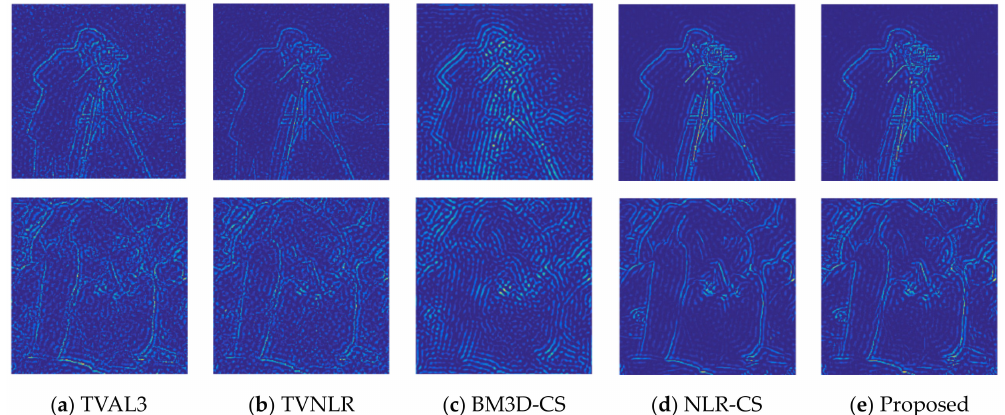
Figure 6. Comparison of high frequency details of the Cameraman(top) and Peppers(bottom) images with ( a ) TVAL3,